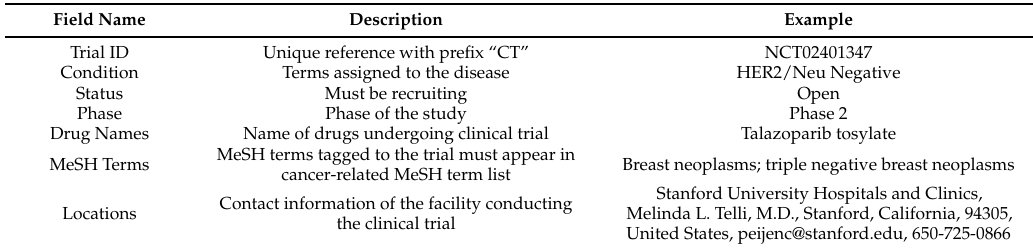
Table 4. List of fields targeted by